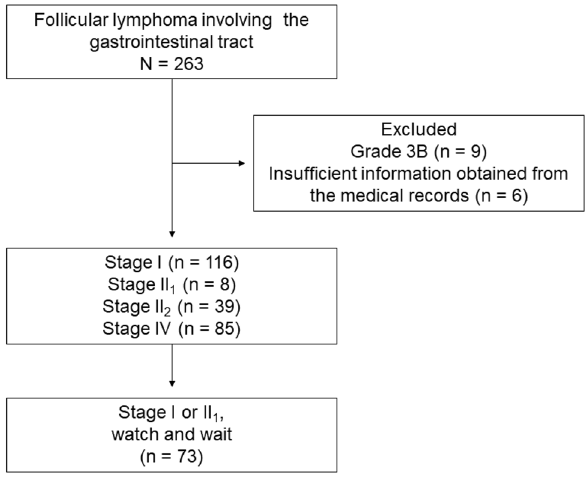
Figure 1. Study flow